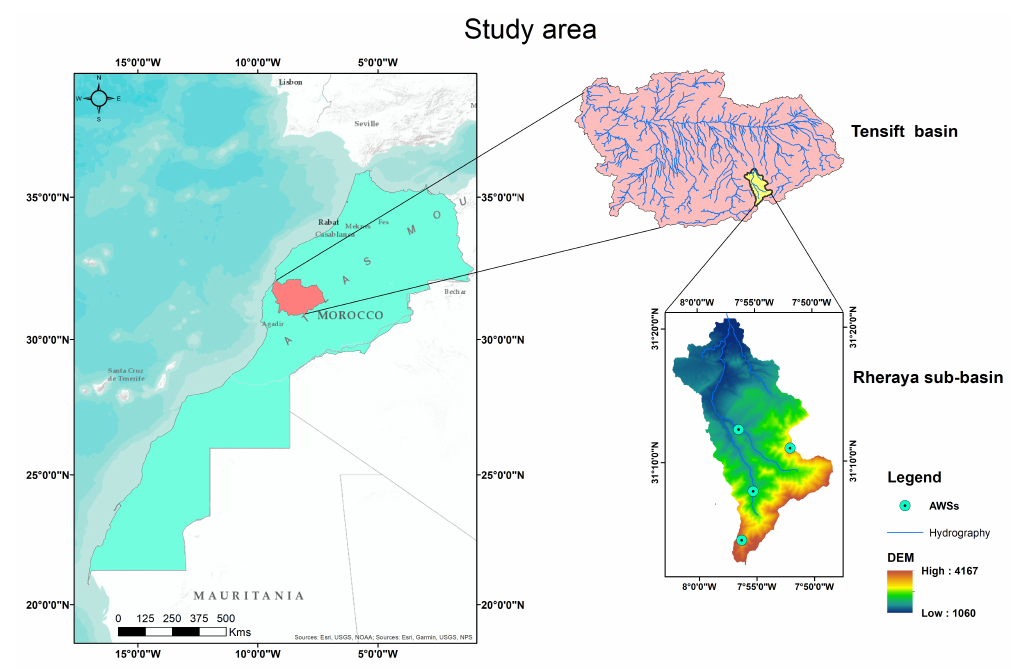
Figure 1. Location of the Tensift basin and Rheraya sub-basin. Table 1. Information regarding the four AWSs installed in the Rheraya sub-basin. The data collection period for all stations extends from 1 January 2016 to 31 December 2020. AWS Latitude Longitude